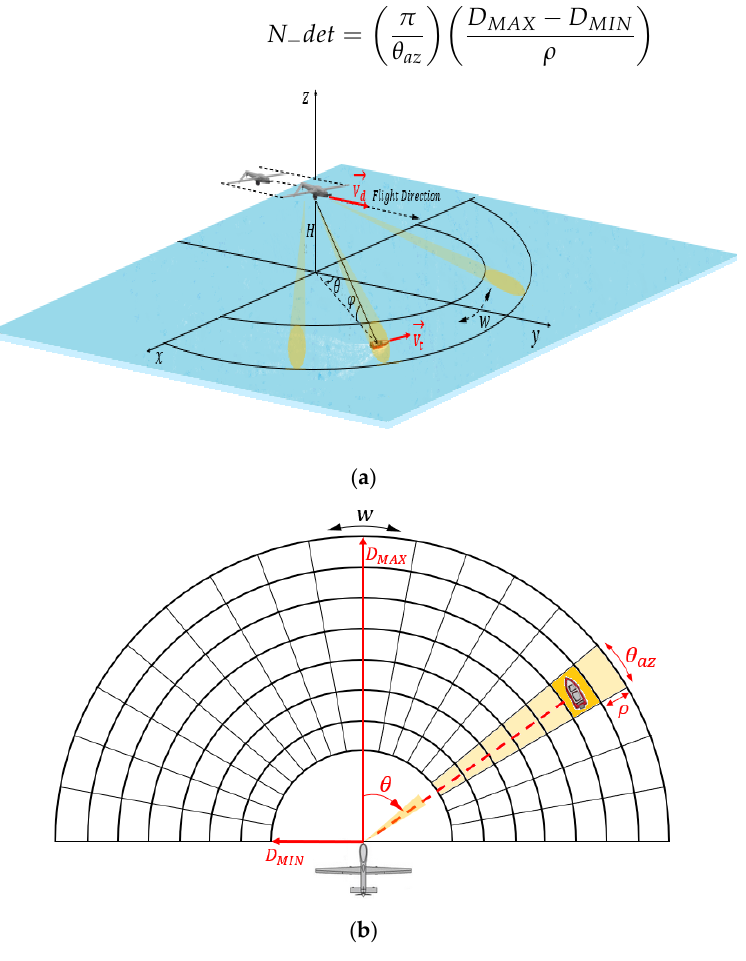
Figure 12. Geometrical configuration of the radar and a target: ( a ) 3D geometry of radar; ( b ) periodic scanning of radar